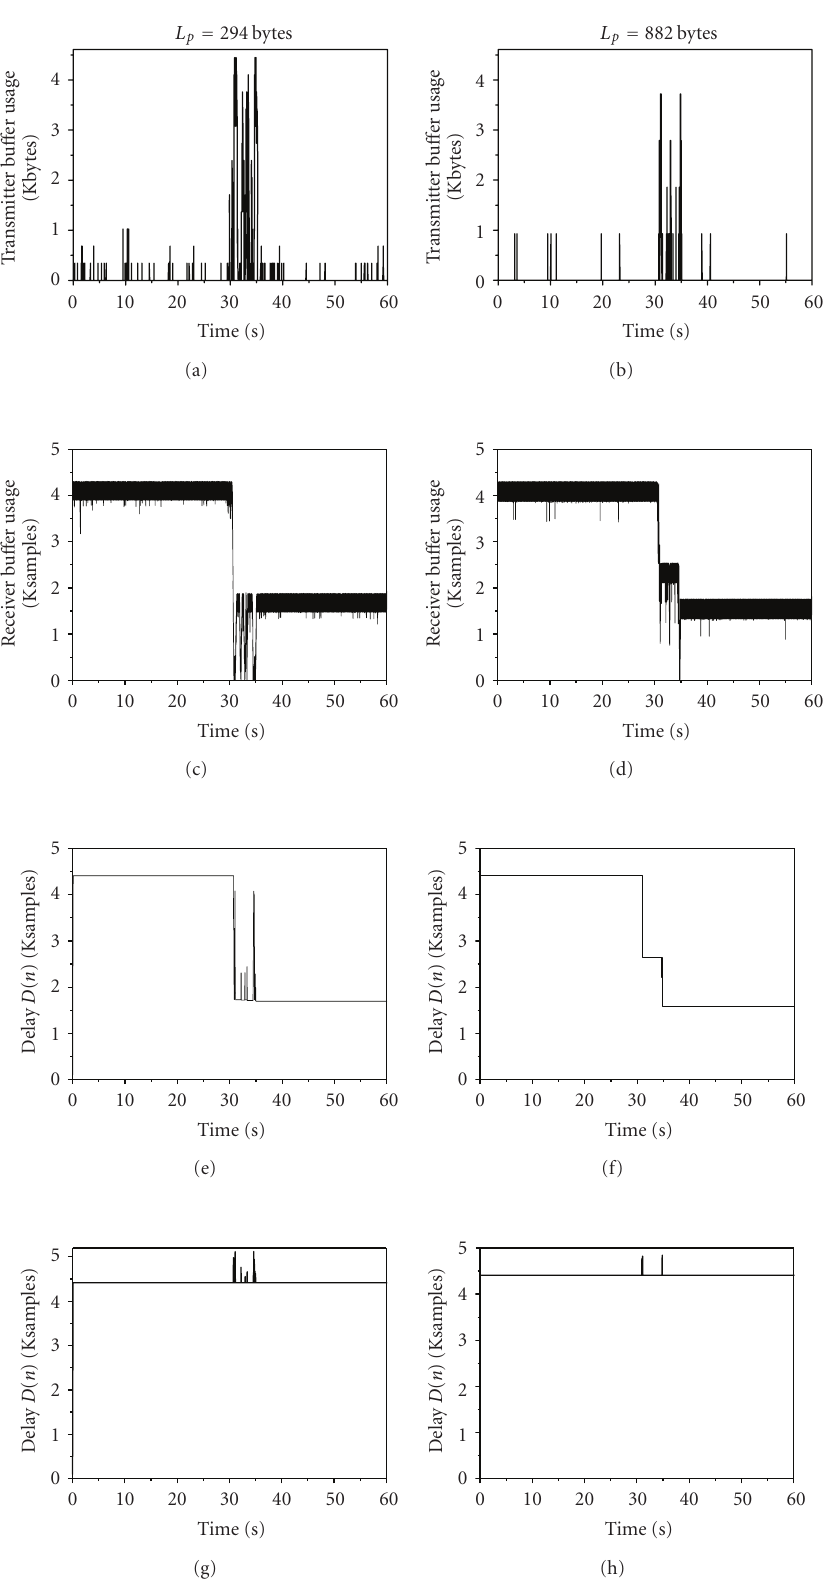
Figure 6: Typical example for time evolution in Tx and Rx bu ff er and end-to-end delay. One channel of a stereo setup is shown for di ff erent packet sizes (for SiS scheduler and medium interference): (a), (b) Tx bu ff er usage; (c), (d) Rx bu ff er usage; (e), (f) delay D ( n ) without CoDeS synchronization; (g), (h) delay D ( n ) with CoDeS